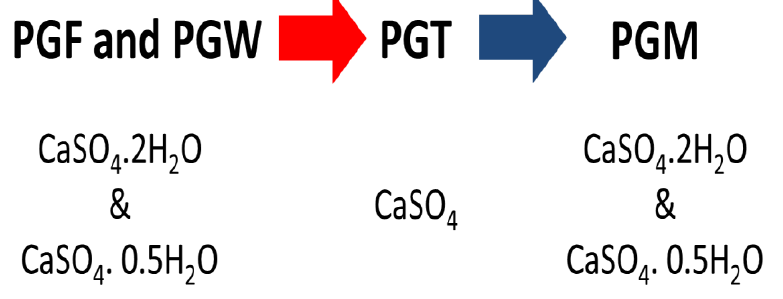
Figure 3. Hydration–dehydration of Figure 3. Hydration – dehydration of PG.